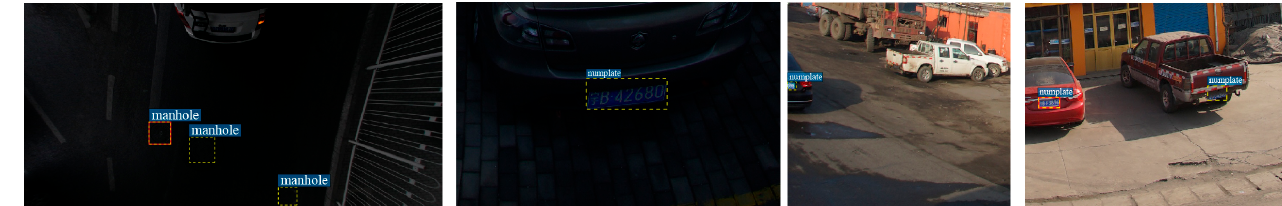
yellow is the ground reference bounding box.